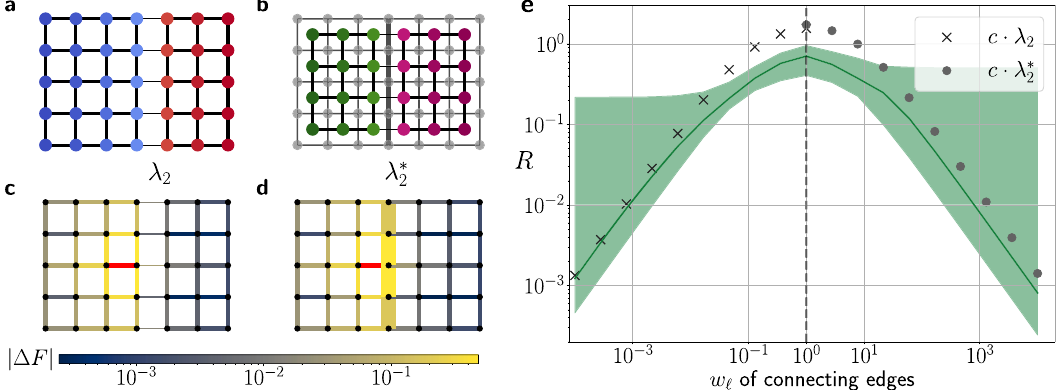
Fig.6|Primalanddualcommunitiesinhibitfailurespreading.a , b Asquaregrid isdividedinto a twoprimalcommunitiesbyweakeningthecentralhorizontaledges or b into two dual communities by strengthening the central vertical edges. The Fiedler vector (color code) reveals the community structure. c , d Both primal and dual communities inhibit fl ow changes ∣ Δ F ∣ (color coded) in the other community after the failure of a single edge (red) with unit fl ow in a given community. e We interpolatebetweenprimalanddualcommunitiesinasquaregridofsize21×10by